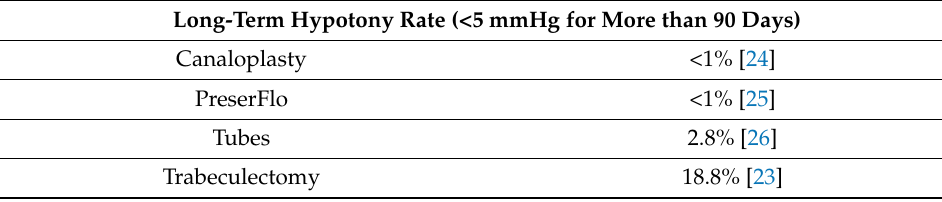
Table 1. Rates of hypotony for different surgical techniques.